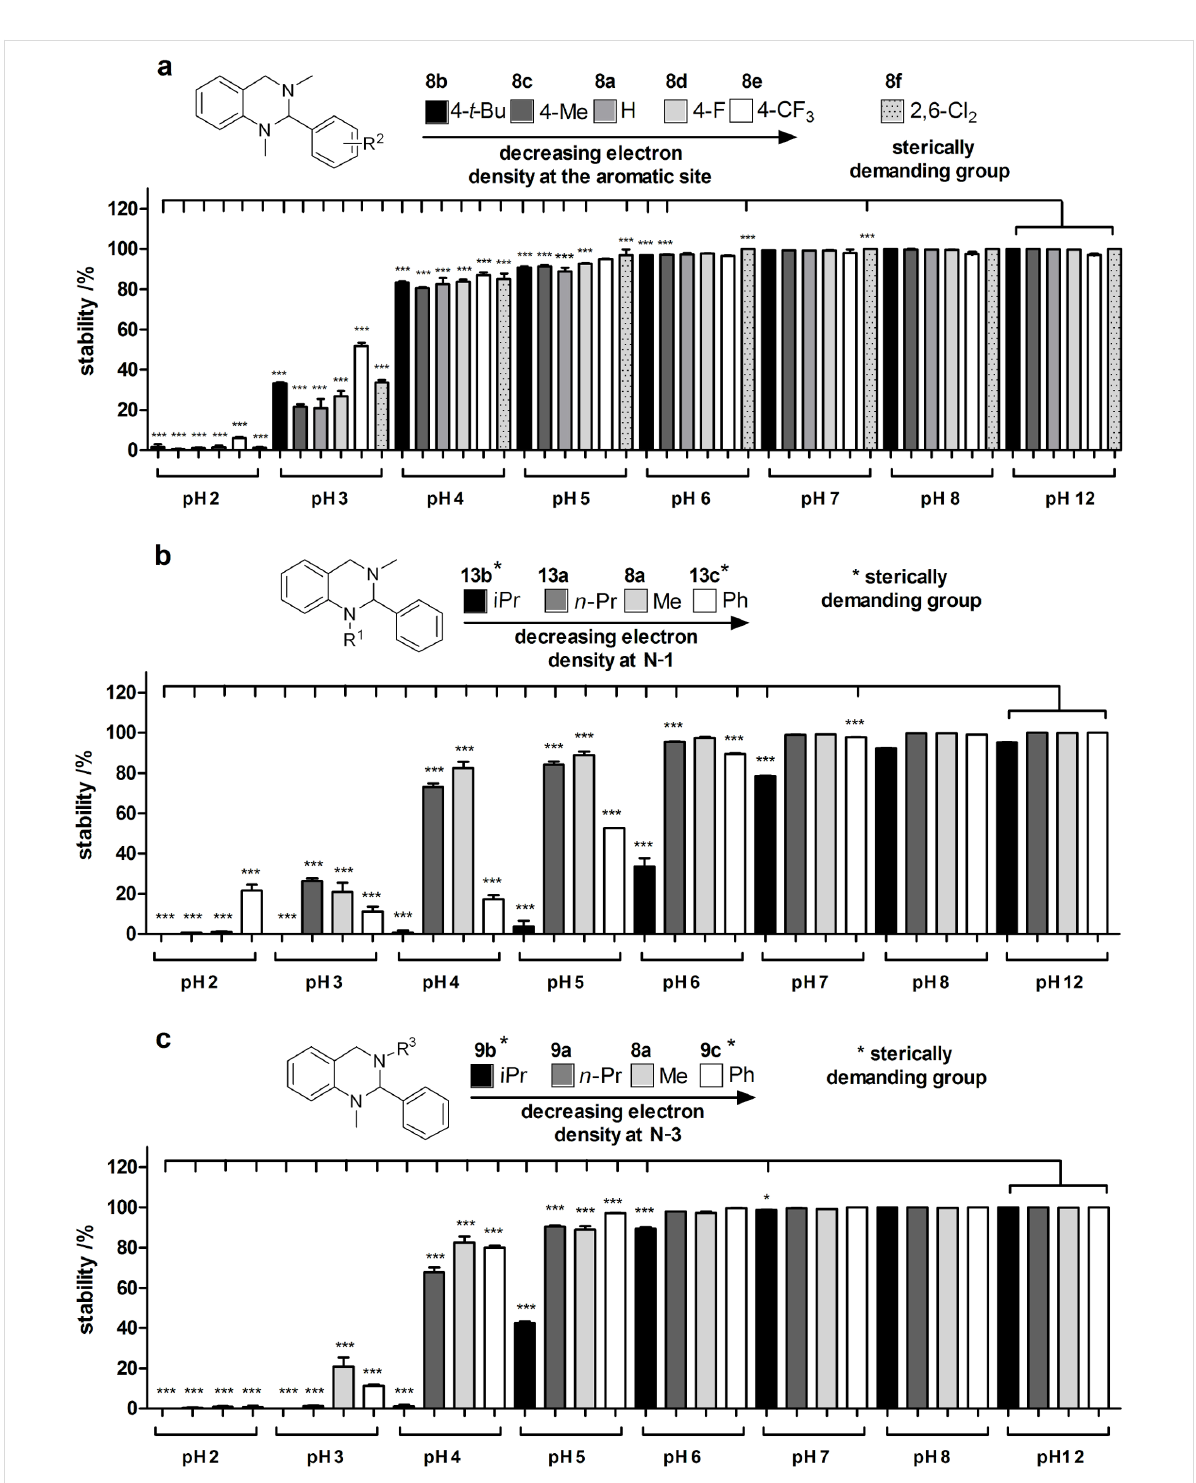
corresponding aldehyde 3 as cleavage product using calibration curves (for a detailed description see Supporting Information File 1). The results of this study are summarized in Figure